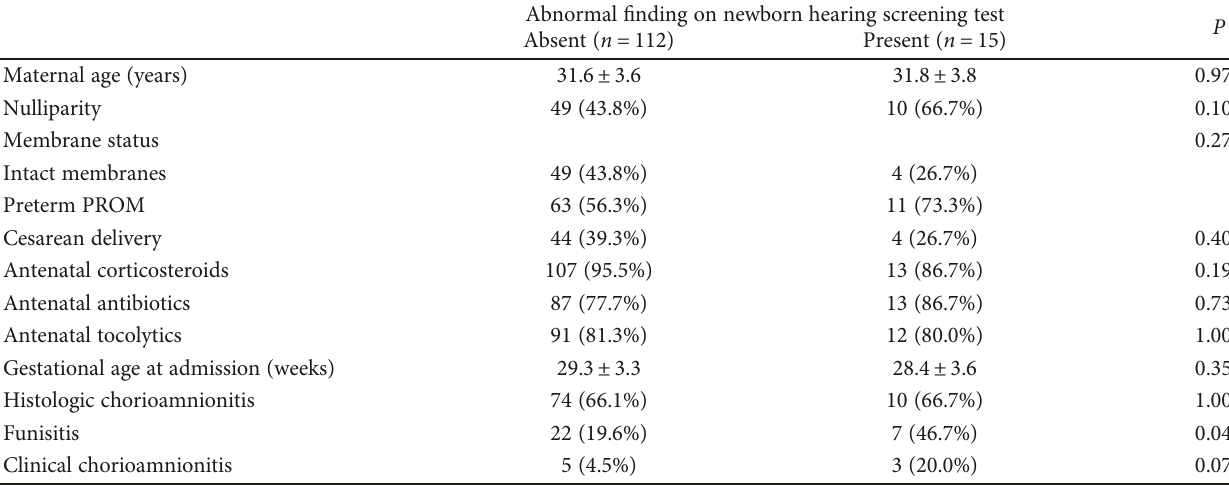
Table 1: Maternal and obstetric characteristics of the study population according to newborn hearing screening test results. Abnormal fi nding on newborn hearing screening